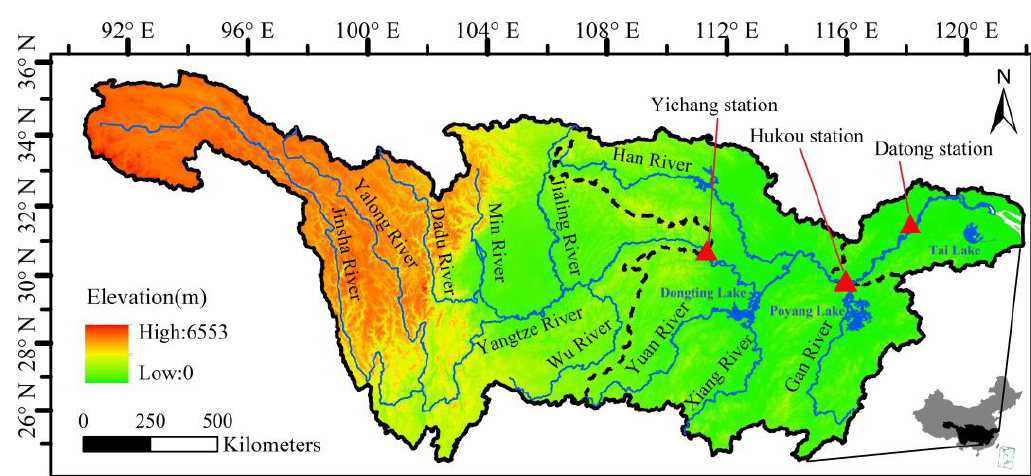
Figure 1. The sub-basin and river network of Yangtze River in China. Note: The black dashed line divides the Yangtze River basin into the upper, middle, and lower reaches.